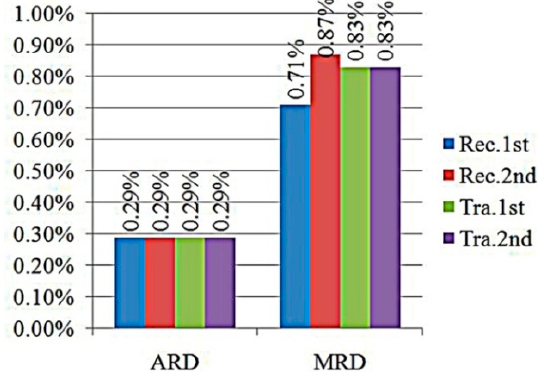
Figure 13. Deviations of density values.